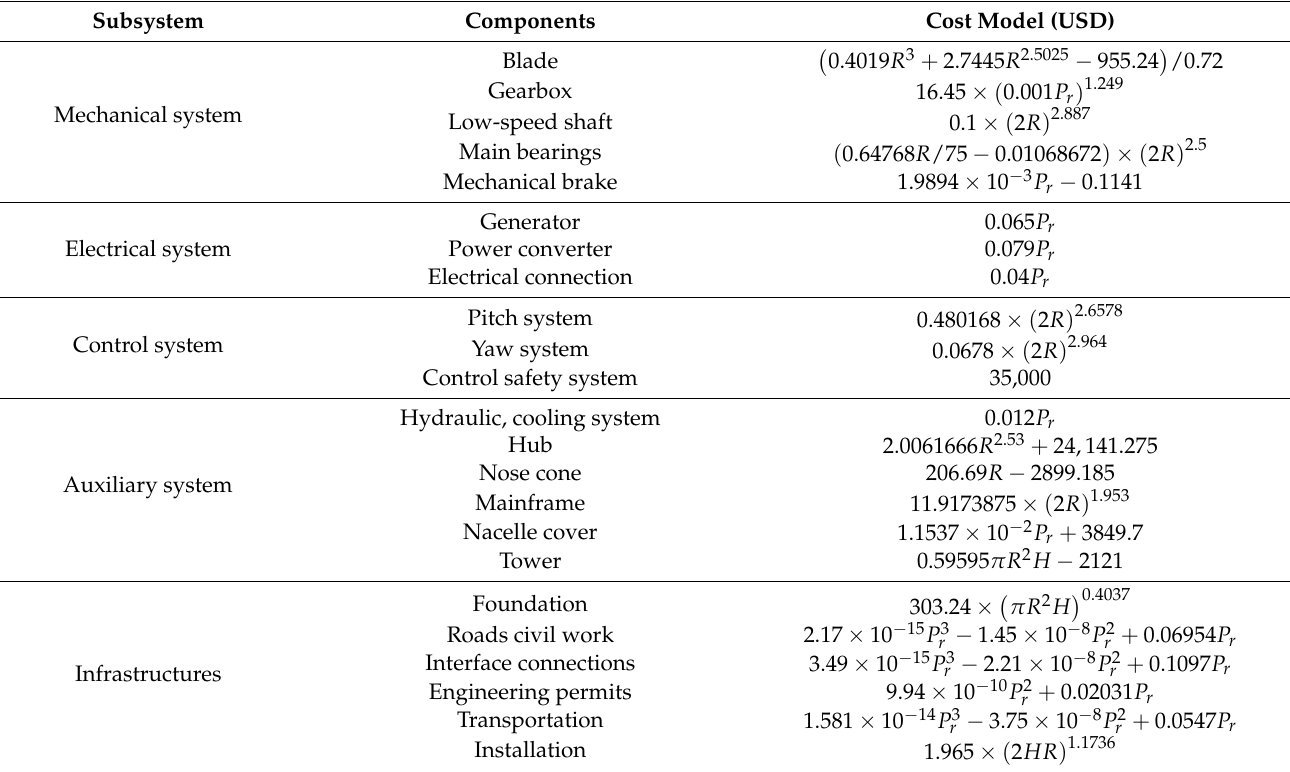
Table 3. The initial capital cost of the wind turbine